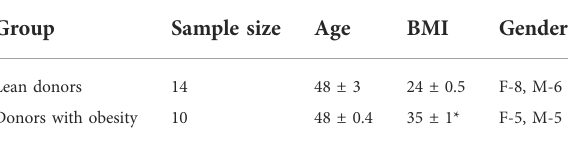
TABLE1Donorcharacteristics.Resultspresentmean±SEM.Statistical signi fi cance was calculated as the difference between for two groups,andthesedifferencesweretestedbypaired t test.* p < 0.05vs. lean donors BMI, body mass index, F, female; M,